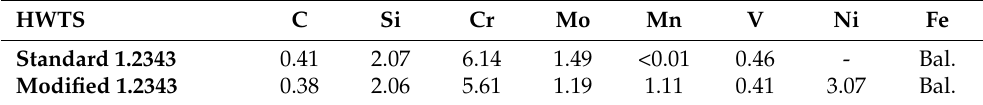
Table 1. The alloy composition